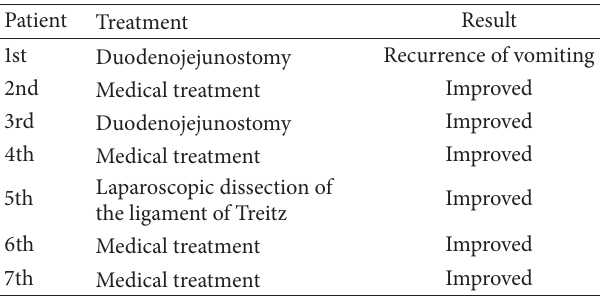
Table 2: Treatment and its